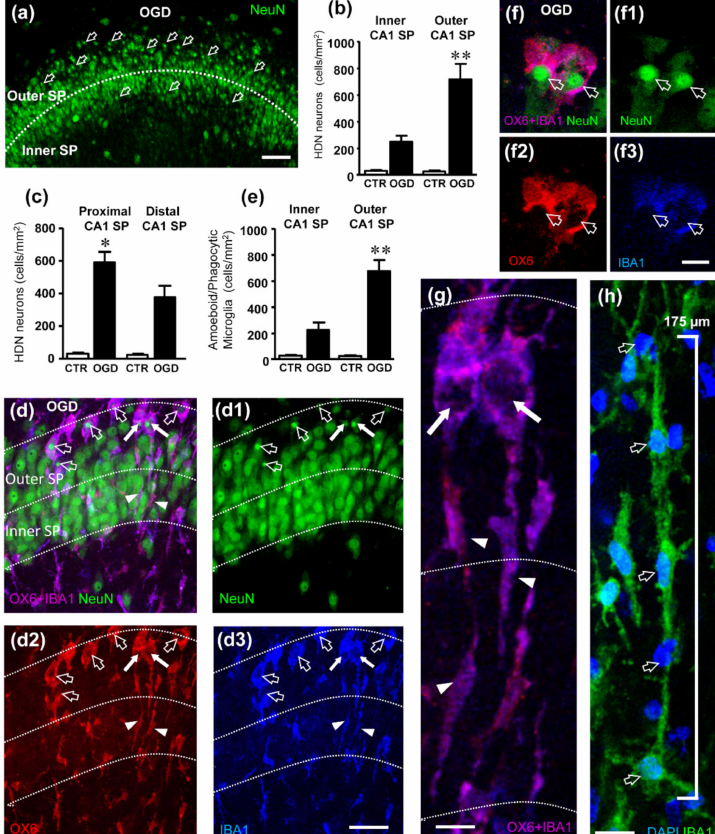
Figure 3. ( a ) Representative confocal images of NeuN-positive neurons (green) in CA1 of an OGD organotypic hippocampal slice. The image was obtained from a single confocal scan captured with a 20 × objective, total thickness 1.2 µ m. The dotted line delineates the inner and outer CA1 SP layers. Numerous HDN neurons (open arrows) are located mainly in the outer layer of CA1 SP. Scale bar: 50 µ m. ( b ) Quantitative analyses of HDN neurons density (cells/mm 2 ) in the inner and outer CA1 SP. Statistical analysis: ** p < 0.01, Outer CA1 SP OGD vs. Inner CA1 SP OGD. ( c ) Quantitative analyses of HDN neurons density (cells/mm 2 ) in the proximal and distal CA1 SP. Statistical analysis: * p < 0.05, Distal CA1 SP OGD vs. Proximal CA1 SP OGD. ( d – d3 ) Representative confocal images of NeuN-positive neurons (green, ( d1 )), OX6-positive active microglia (red, ( d2 )) and IBA1-positive total microglia (blue, ( d3 )) in CA1 of an OGD organotypic hippocampal slice captured with a 63 × objective. The merge of the three immunofluorescent staining is shown in ( d ) in which the pink-purple color is indicative of active (OX6-positive) microglia cells (IBA1-positive). The images were obtained stacking 10 consecutive confocal scans (z step 0.3 µ m, total thickness 3 µ m). Numerous active microglia cell bodies phagocytosing HDN neurons are present in the outer CA1 SP (open arrows). The dotted lines delineate the inner and outer CA1 SP. Scale bar: 25 µ m. ( e ) Quantitative analyses of the density of phagocytic microglia (cells/mm 2 ) in the inner and outer layers of CA1 SP. Statistical analysis: ** p < 0.01, Outer CA1 SP OGD vs. Inner CA1 SP OGD. In the bar graphs, each bar represents the mean ± SEM of 7–9 independent slices. All statistical analyses were performed by Student’s paired t test. ( f – f3 ) Representative confocal images of NeuN-positive neurons (green, ( f1 )), OX6-positive active microglia (red, ( f2 )) and IBA1-positive total microglia (blue, ( f3 )) in CA1 of an OGD organotypic hippocampal slice captured with a 63 × objective. The merge of the three immunofluorescent staining is shown in ( f ). The images were obtained stacking 10 consecutive confocal scans (z step 0.3 µ m, total thickness 3 µ m) taken in the outer CA1 SP and show two active (OX6-positive, ( f2 )) microglia cells phagocytosing HDN neurons. Scale bar: 10 µ m. ( g ) Enlargement of the IBA1-positive (blue) and OX6-positive (red) microglia cells indicated by the white arrows in ( d ). The images were obtained stacking 10 consecutive confocal scans (z step 0.3 µ m, total thickness 3 µ m) and show rod